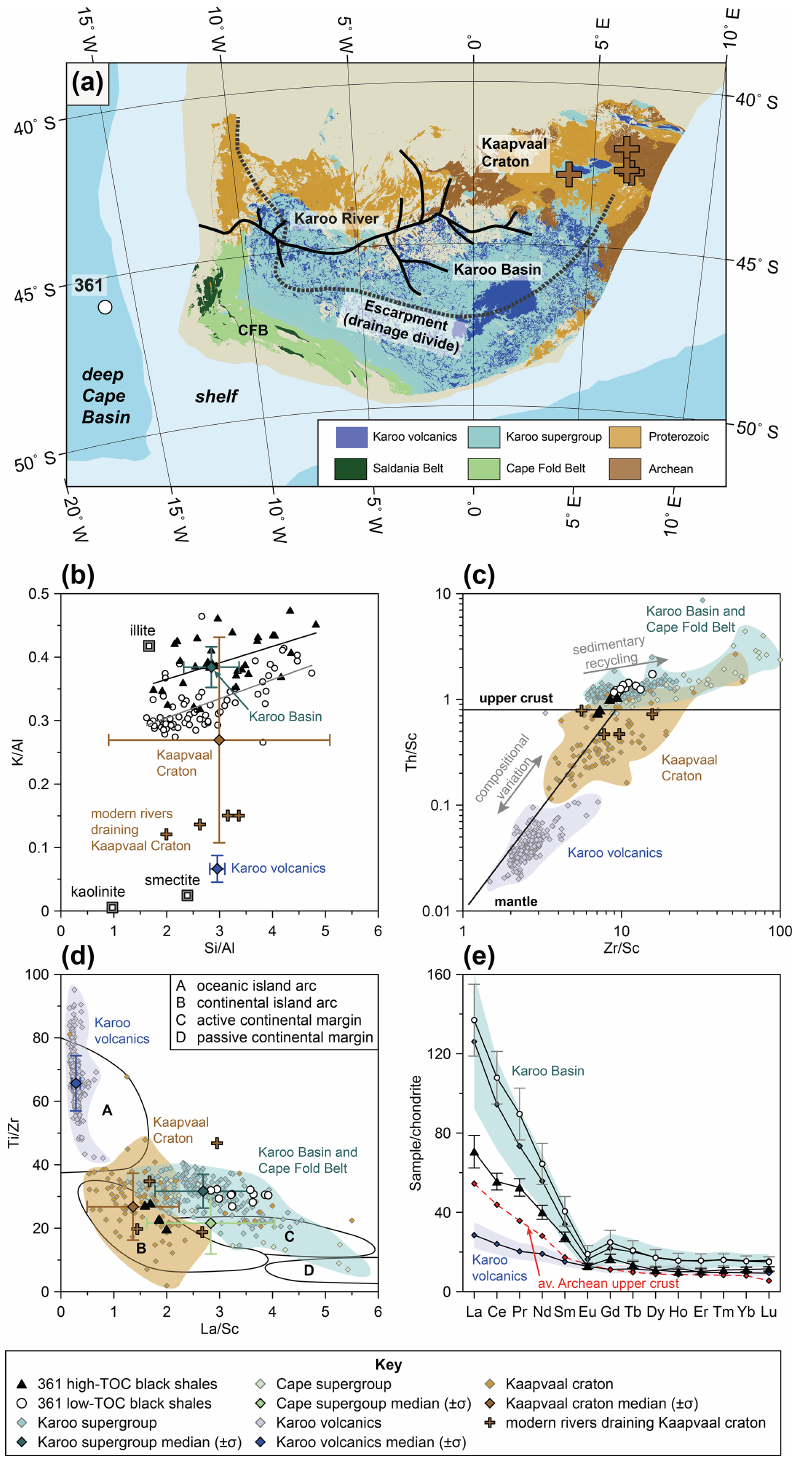
Figure 4. Provenance assessment of Early Aptian black shales based on major and trace metal discrimination plots: (a) geological map of southern Africa showing potential sediment source areas. Early Cretaceous paleo-drainage reconstruction adapted from De Wit (1999). Panel (b) shows cross-plots of Si / Al and K / Al. Average elemental composition of different clay minerals was taken from Weaver and Pollard (1973). Panels (c) and (d) show cross-plots of Zr / Sc vs. Th / Sc (McLennan et al., 1993) and La / Sc vs. Ti / Zr (Bhatia and Crook, 1986), respectively. Panel (e) shows chondrite-normalized rare-earth element distributions. Trace element data for source areas were compiled from the literature. Data and references are provided in Supplements files S2 and